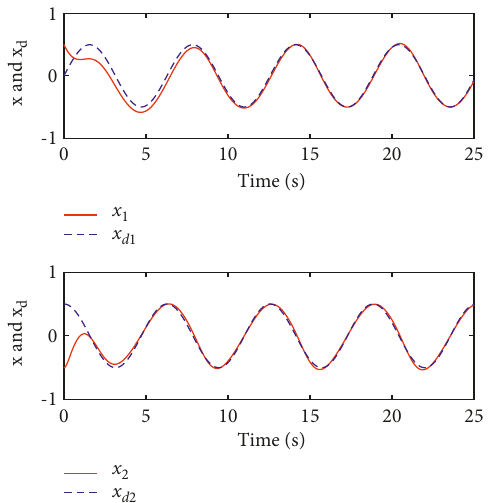
Figure 8: Tracking performance for uncertain system (44) with (34) (case 2).